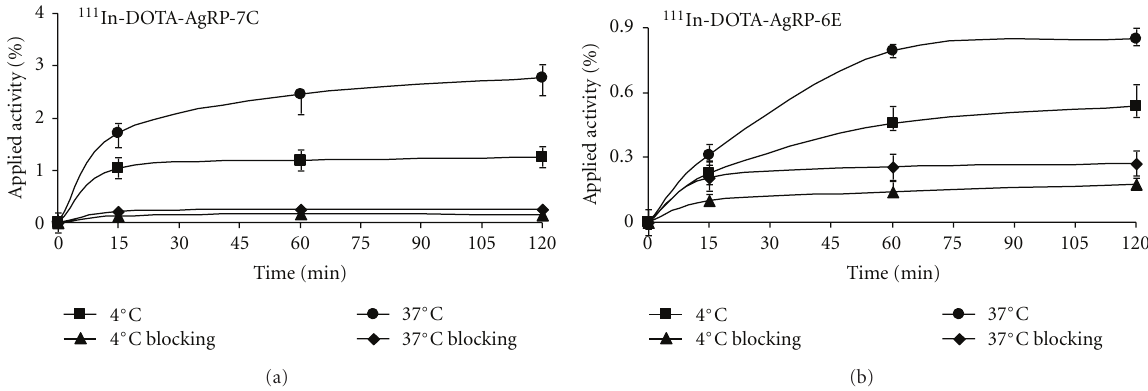
Figure 2: In vitro cell uptake assay of 111 In-DOTA-AgRP-7C (a) and 111 In-DOTA-AgRP-6E (b) on U87MG cells at 37 ◦ C and 4 ◦ C with or without c(RGDyK) blocking peptide ( n = 3, mean ±